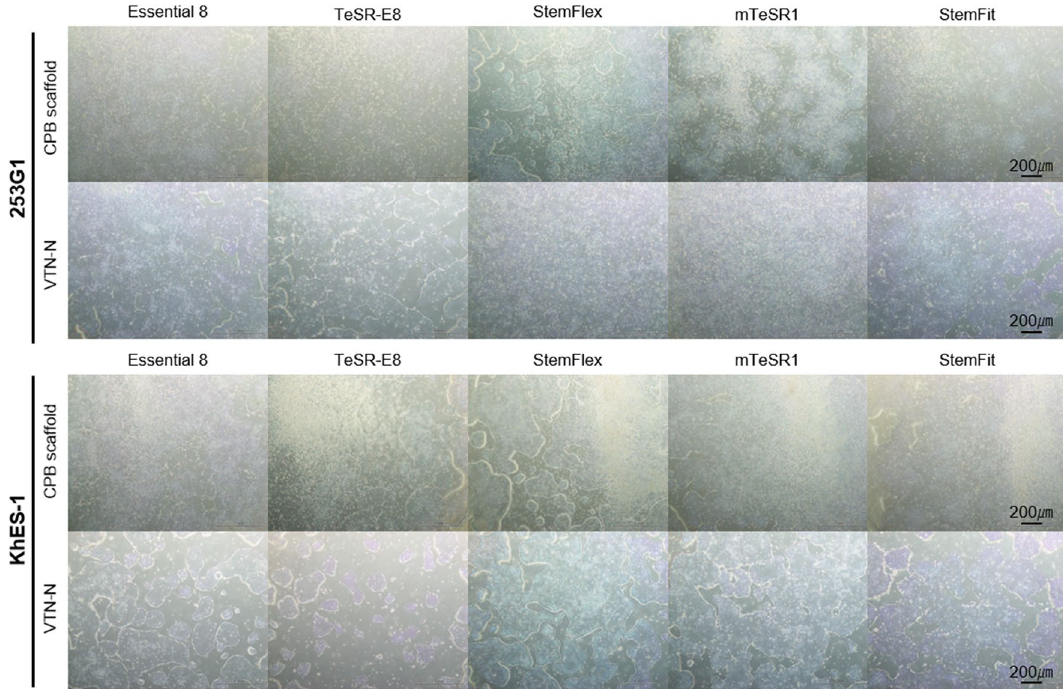
Figure 5. Examination colony formation and cell number on CPB scaffold using multiple media. Colony formation of 253G1 and KhES-1 cells after 5 days in Essential 8, TeSR-E8, StemFlex, mTeSR1, or StemFit cultures. CPB scaffold or VTN-N were used as the culture substrate. All scale bars are 200